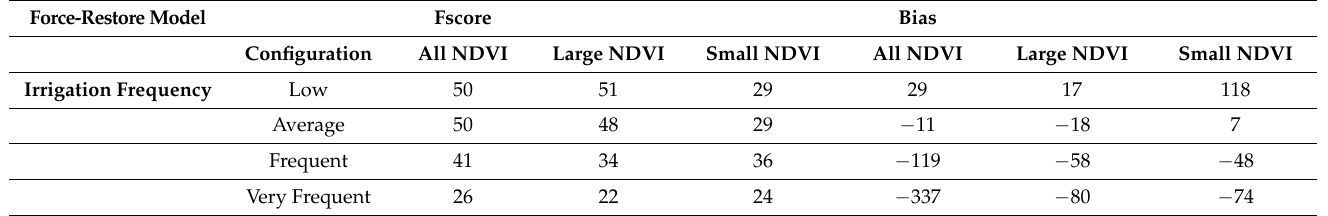
Table 4. Scores (F-score, bias) of the force-restore model according to irrigation frequency and NDVI.